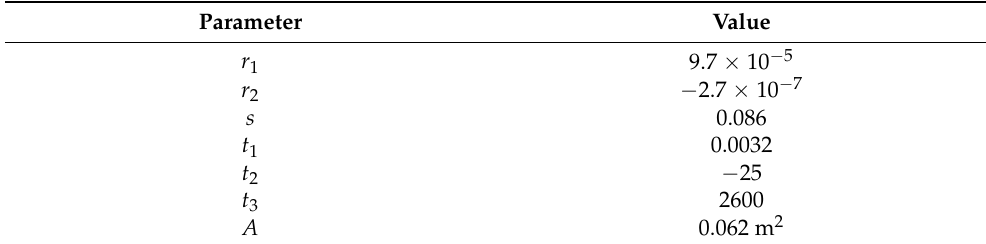
Table 1. Parameters of the electrolyzer